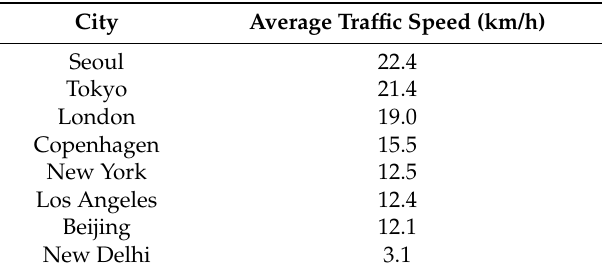
Table 1. Average traffic speed of traffic in urban agglomerations